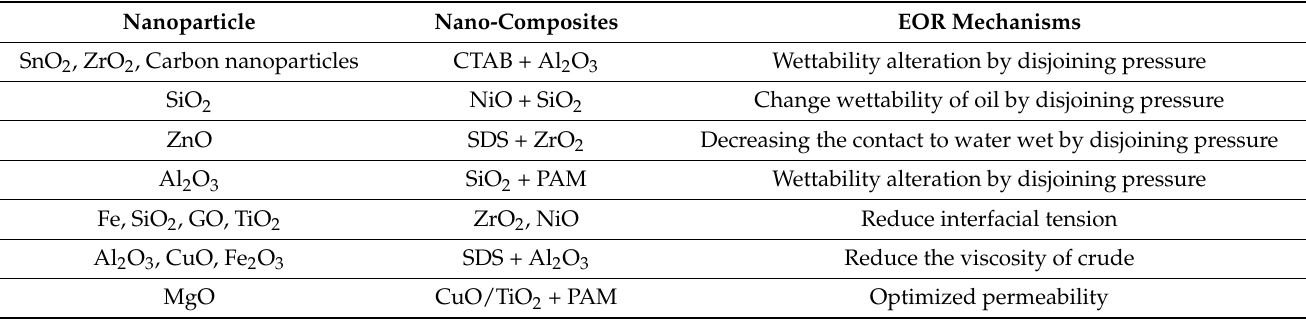
Table 4. Role of different nanoparticles in EOR mechanisms.